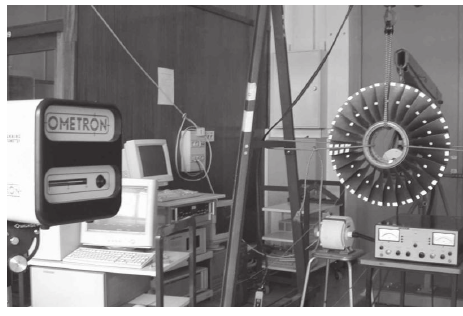
Figure 4: Global experimental